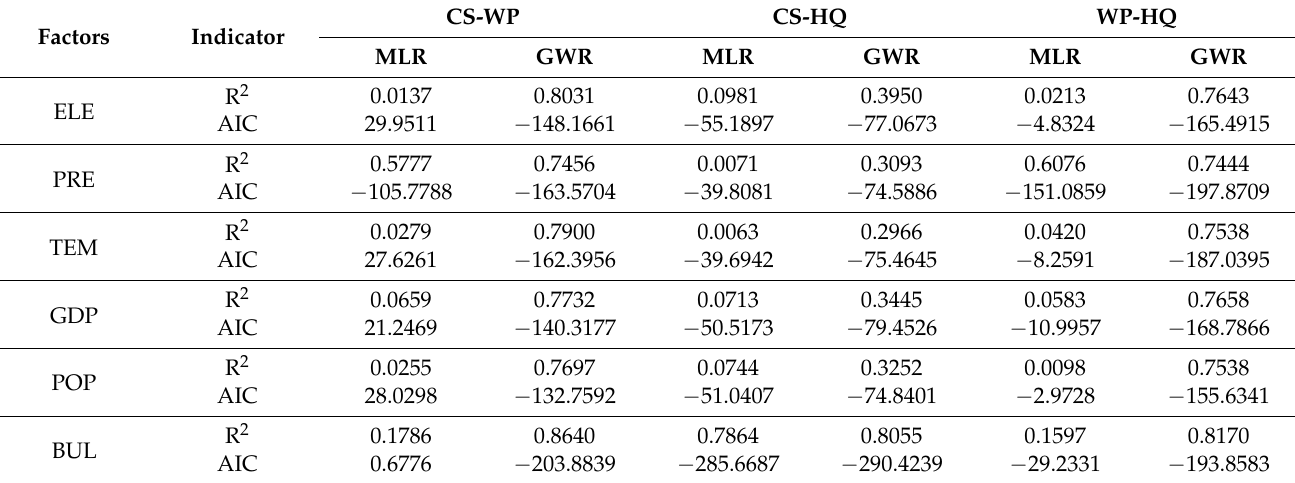
Table 5. R 2 and AIC values for the GWR and MLR